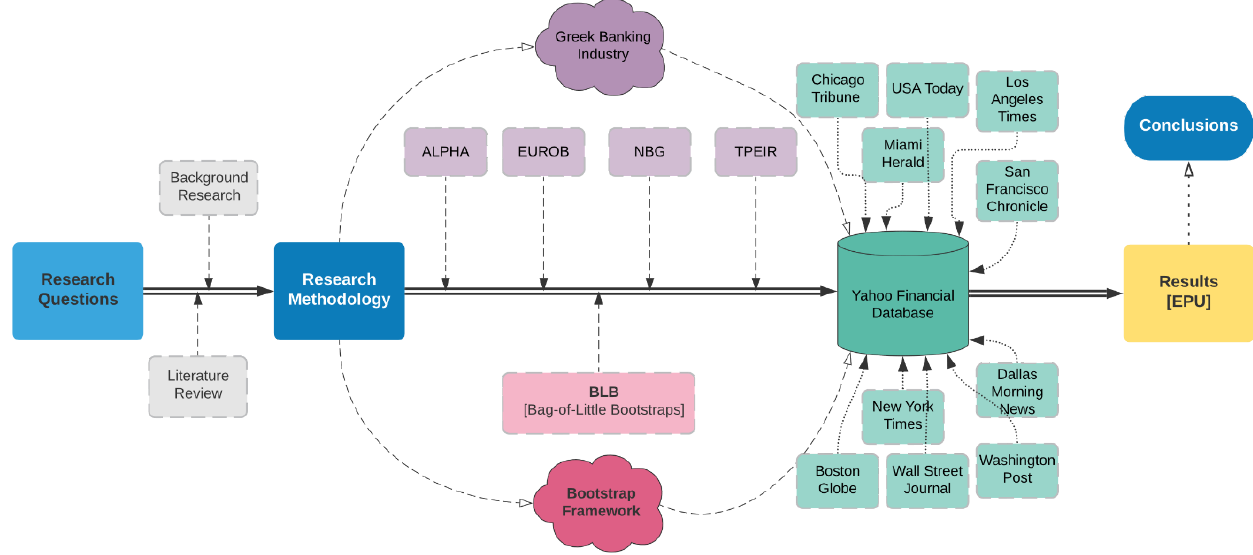
Figure 1. Flowchart of Research